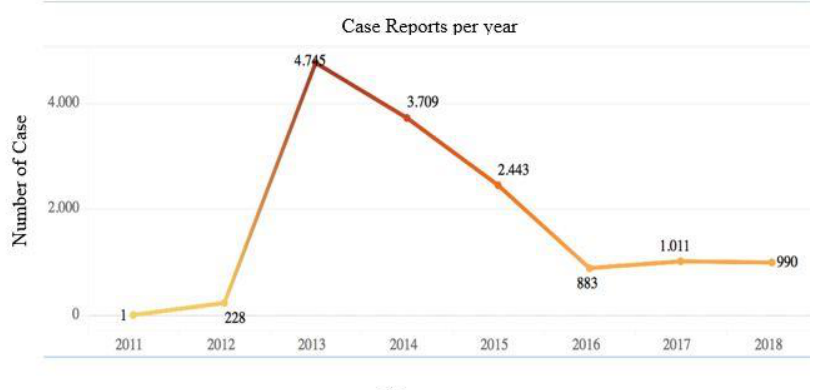
Figure 1: Statistics of Drug